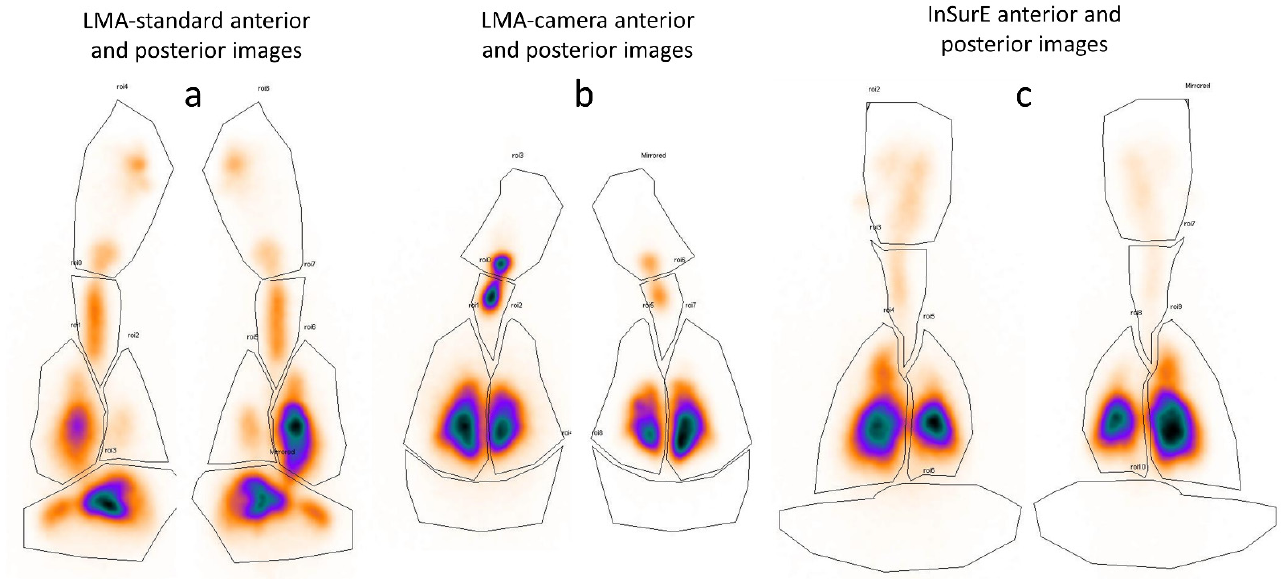
Figure 5. Typical images obtained from the gamma camera for one animal in each group. Panel ( a ), anterior and posterior images of a subject in the group with the laryngeal mask airway standard; panel ( b ), anterior and posterior images of a subject in the group with the laryngeal mask airway with a camera; panel ( c ), anterior and posterior images of a subject in the group with the intubation-surfactant-extubation (InSurE). The median time between surfactant administration and imaging was 52 min (41–91), median (range).